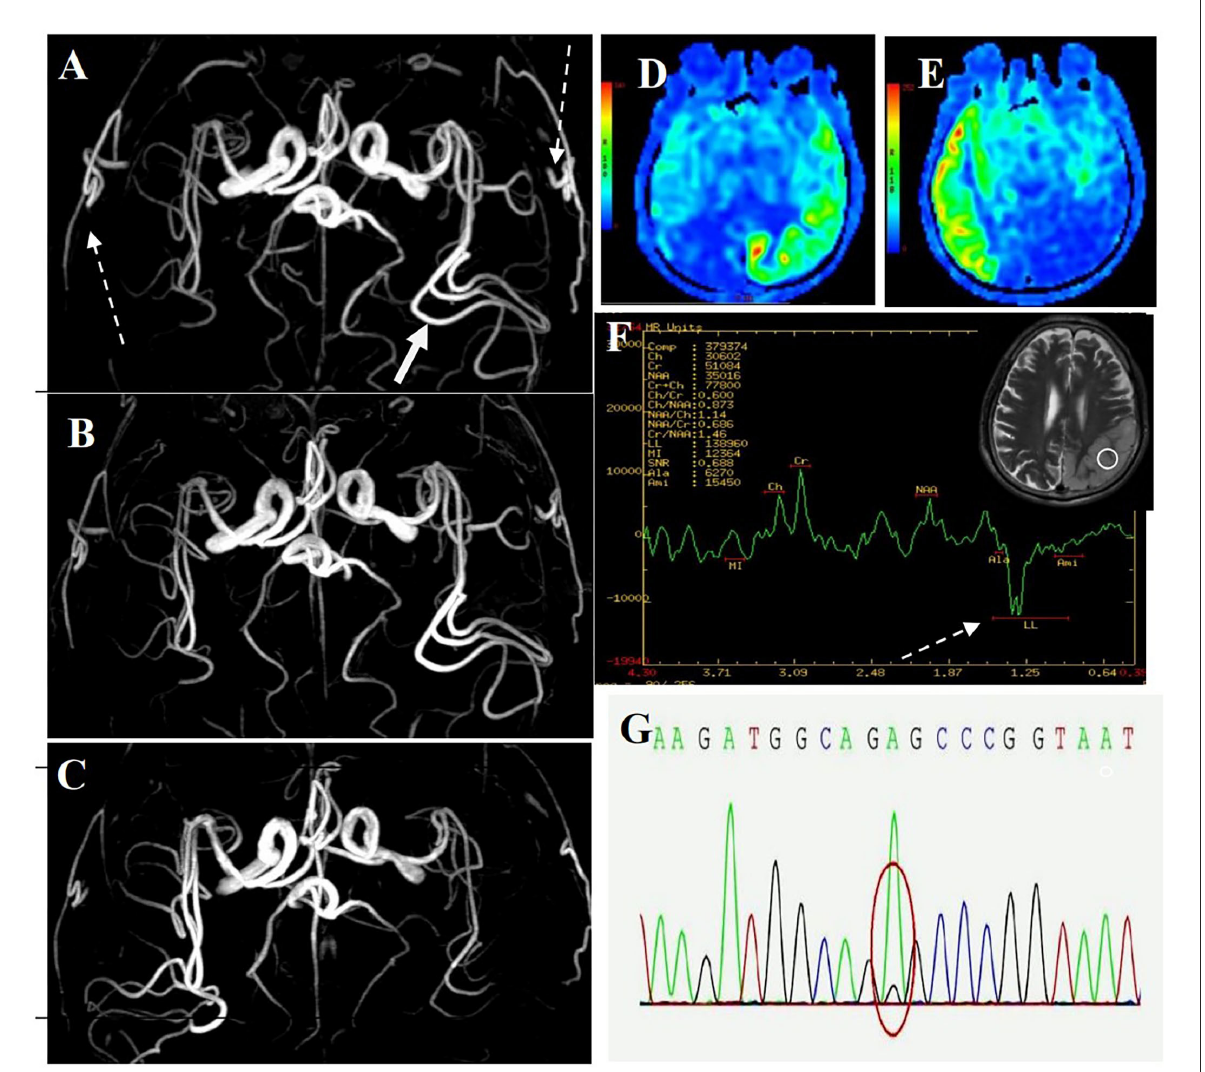
FIGURE2 MR images of the patient. (A) MRA image of first onset period, 12 days after onset. MRA showed dilation of the left middle cerebral artery (long-tail arrow), with apparent dilation of superficial temporal arteries (long dotted arrow). (B) MRA image of remission period, 27 days after onset. MRA showed that the superficial temporal arteries were retracted. (C) MRA images of recurrence period, 68 days after onset. MRA showed that the left middle cerebral artery appeared normal, and the right middle cerebral artery was dilated. (D) ASL image of first onset period, 12 days after onset. ASL showed hyperperfusion in the left occipital-temporal-parietal focal areas. (E) ASL images of recurrence period, 68 days after onset. ASL showed hyperperfusion in the right occipital-temporal-parietal focal regions. (F) MRS image of first onset period, 12 days after onset. MRS showed a double inverted lactate peak at 1.33 ppm (short dotted arrow). (G) Genotypic detection analysis showed mitochondrial mutation (m.3243A >